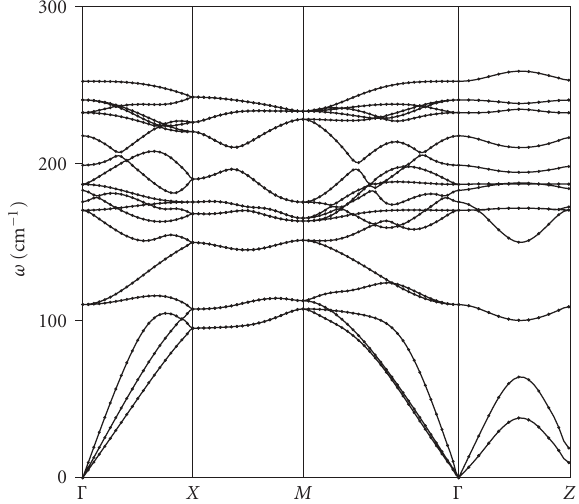
Figure 4: Phonon dispersion curves in NaFeAs, plotted along high symmetry directions of the Brillouin